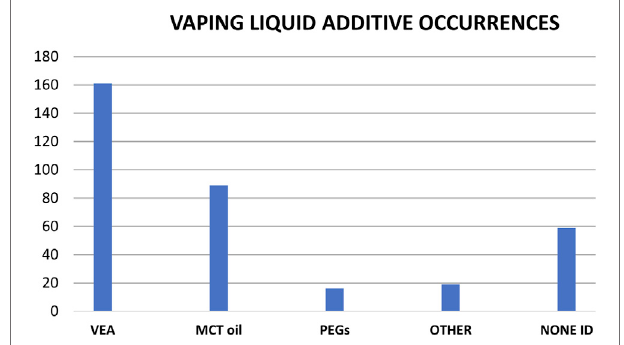
FIGURE 11 | Number of vaping liquid additives occurrences in a composite grouping ofca. 300 vaping liquids representing both EVALI patient associated and independent investigations. See text for